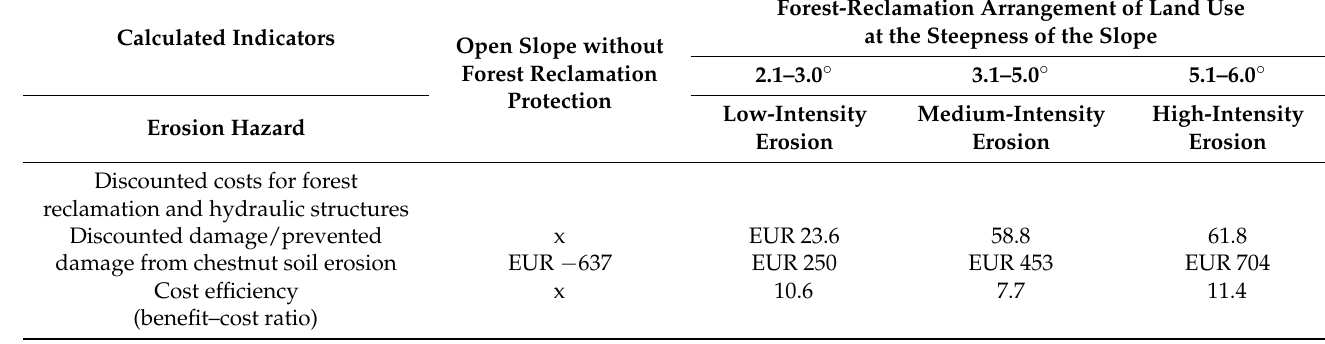
Table 4. Cost-effectiveness of protective afforestation measures on the slope lands of the dry-steppe zone of the Lower Volga region (per 1 ha of forested land